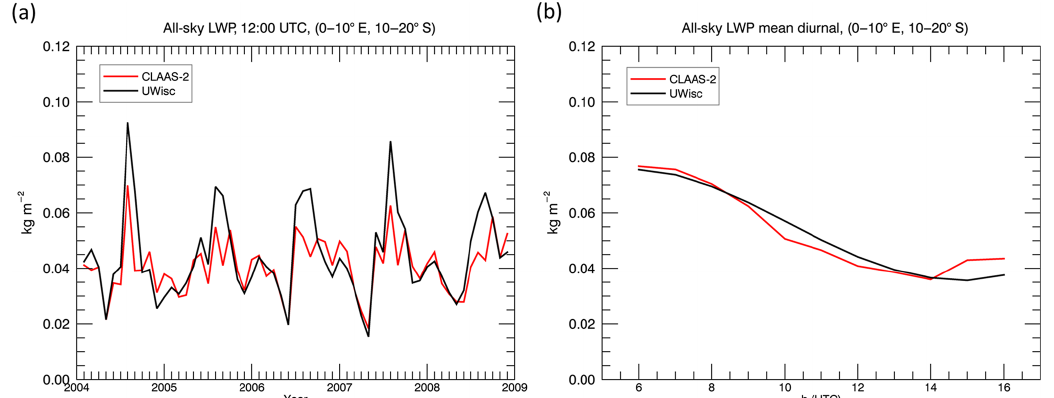
Figure 9. (a) Time series of the monthly all-sky LWP over the marine Sc region (0–10 ◦ E, 10–20 ◦ S) at 12:00UTC from CLAAS-2 and UWisc data. (b) Monthly mean diurnal cycle of all-sky LWP from CLAAS-2 and UWisc over the same